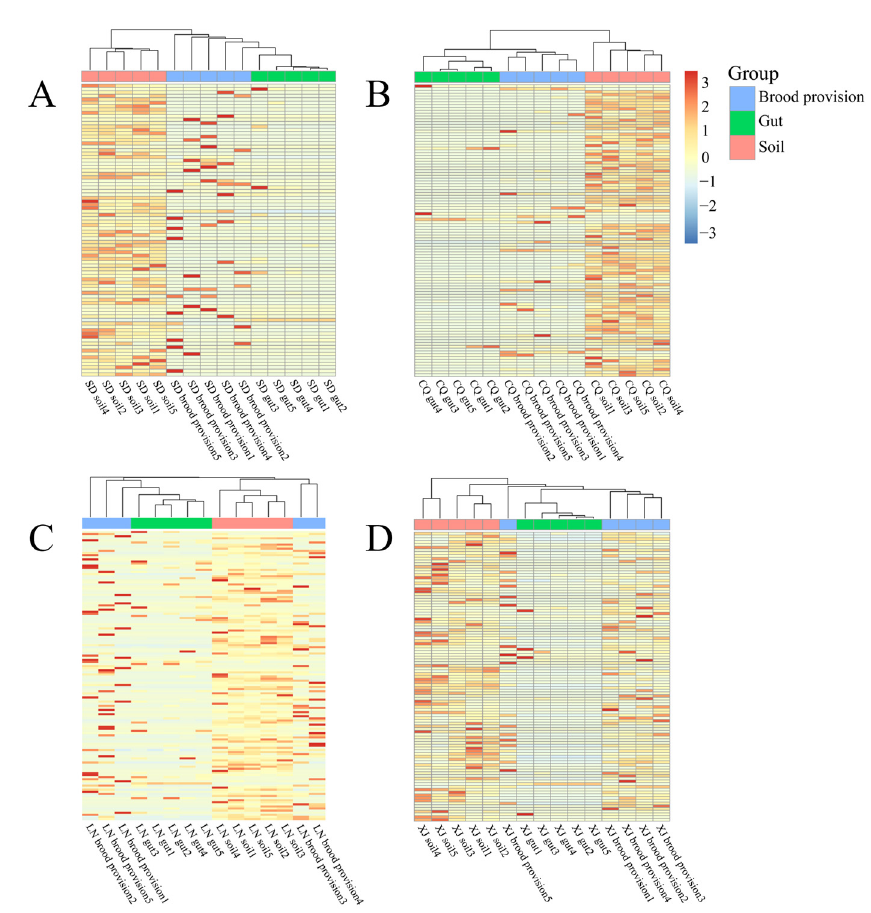
Figure 3. The cluster analysis of larvae gut, brood provision and soil bacterial community composi ‐ tion of O. excavata in different plots (( A ) SD; ( B ) CQ; ( C ) LN; and ( D ) XJ).